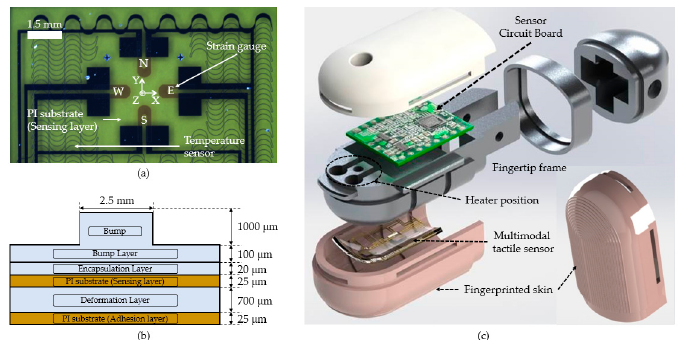
Figure 1. Conceptual diagram of a robot fingertip module with multimodal tactile sensing capability. ( a ) An optical image about the sensing layer of the multimodal tactile sensor (w/o bump). ( b ) Cross- sectional view of a multimodal tactile sensor and its dimension. ( c ) 3D exploded view of the developed robot fingertip module with fingerprinted silicone